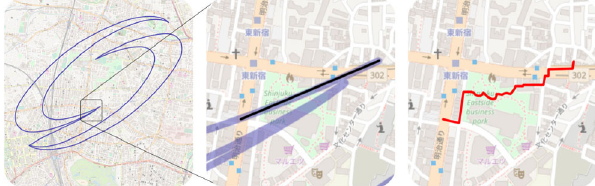
Fig. 5 Left to right: placing a user-drawn figure on the map, selecting the first segment depending on the minimum segment length, and computing the path of the